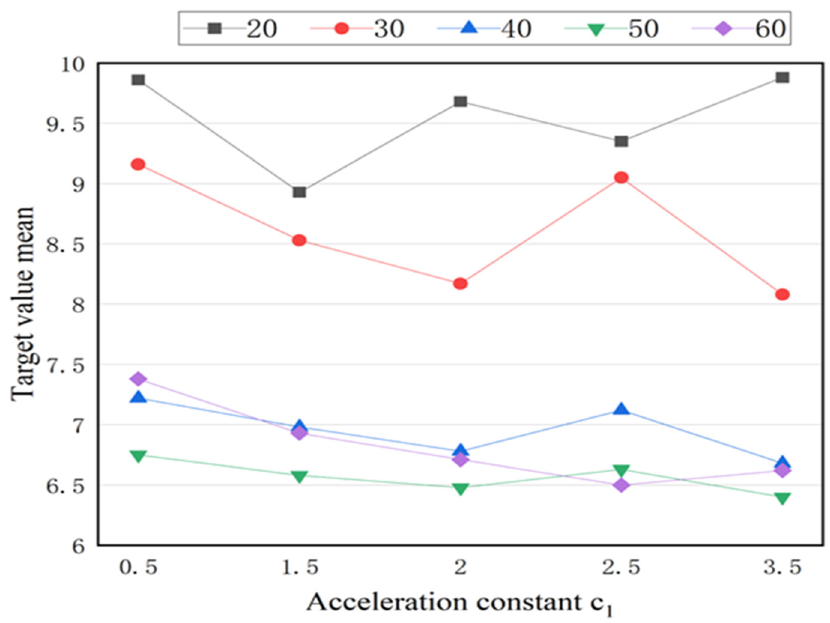
Figure 6. Parameter test result of the PSO algorithm.